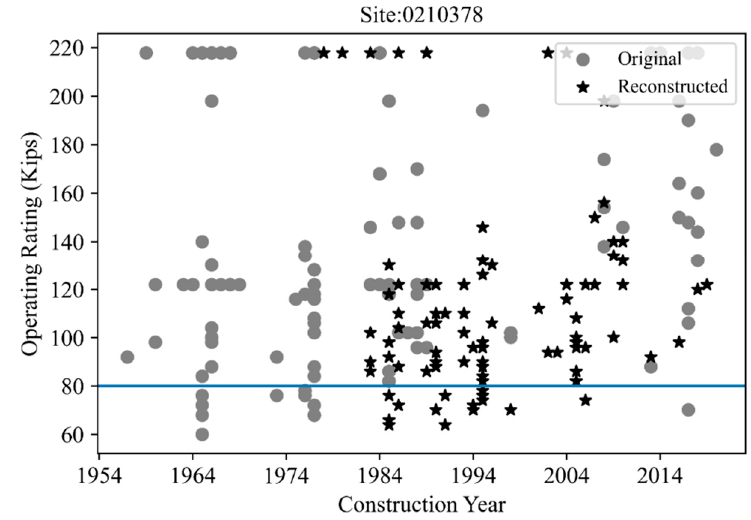
Figure 7. Bridge reliability in percentage for routes ( a ) I-75, ( b ) I-95, ( c ) I-16, and ( d ) I-20.